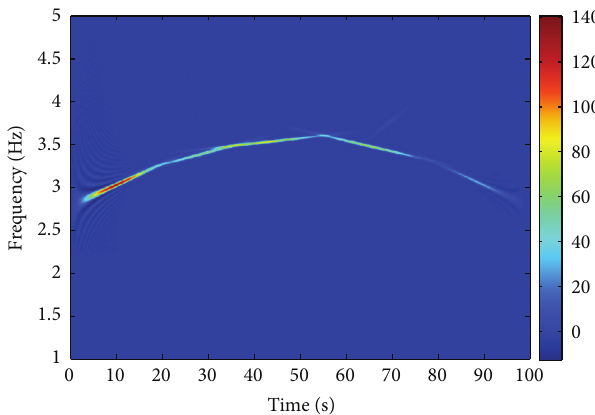
Figure 11: CT spectrogram of displacement response of case 2.